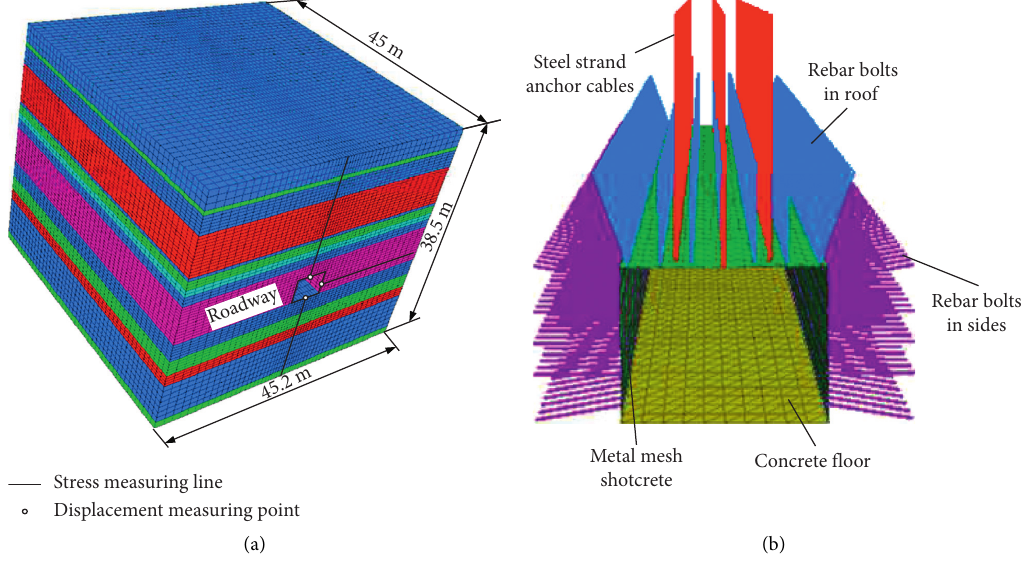
Figure 4: Numerical model of roadway excavation. (a) Grid model. (b) Supporting structure.